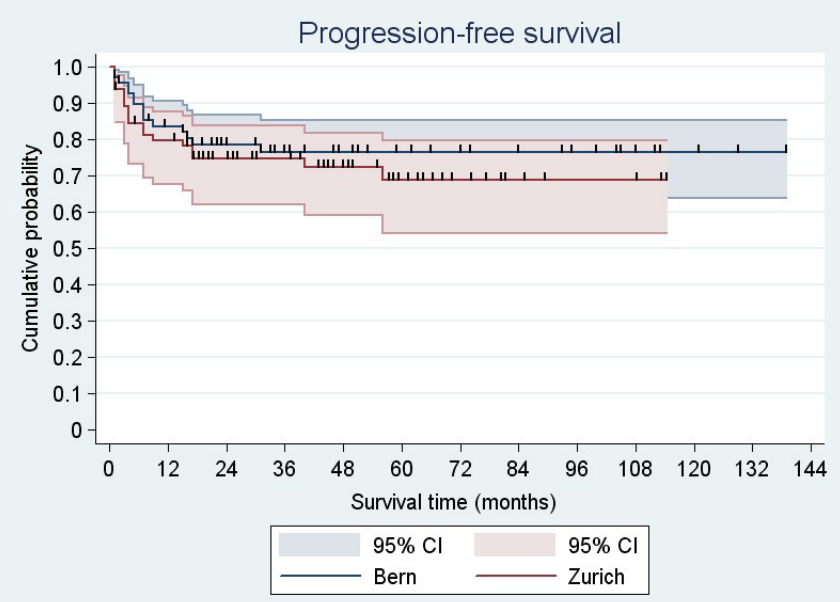
Kaplan-Meier analysis of progression-free survival after stratification for centre. Bern progression-free survival at 5 years 77% (95% CI: 64–85%);